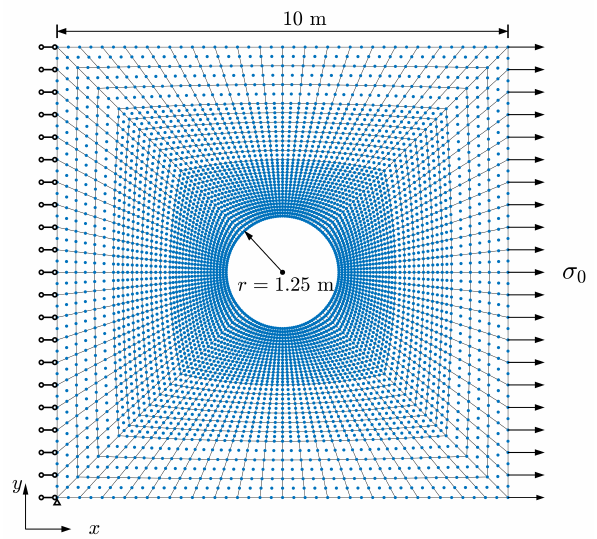
Figure 2. Sketch of the plate with hole problem and its finite element